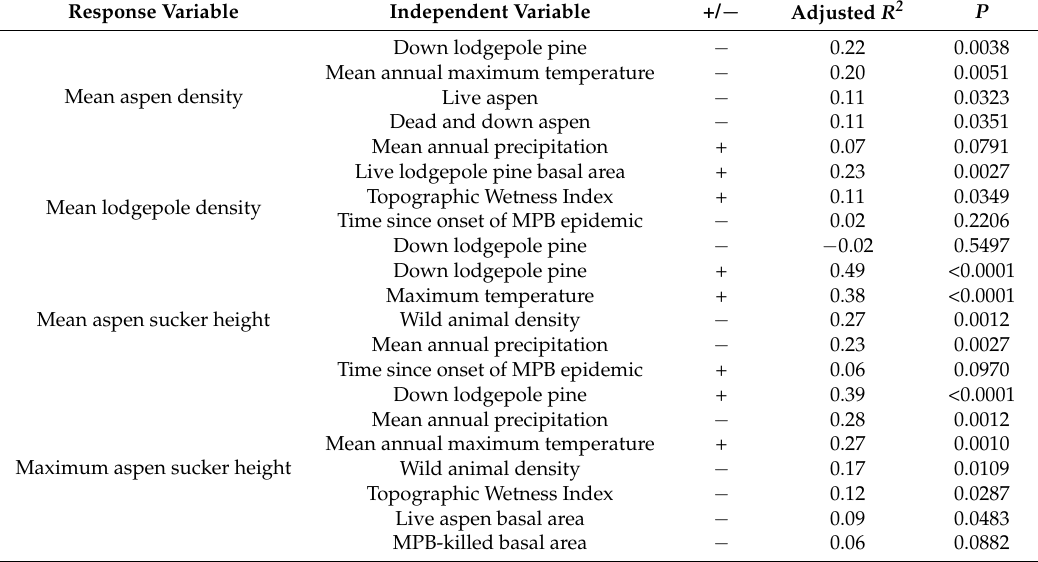
Table 2. Results of linear regression analysis of regeneration density (aspen and lodgepole pine), height (aspen), and independent variables. Independent variables are listed in order of the strength of their relationship with the response variable (as measured by adjusted R 2 ). All independent variables shown had a significant ( α < 0.1) Spearman’s rank correlation with the response variable. Signs (+ or − ) indicate if regression relationship is positive or negative. All variables met assumptions of normality; all variables were log-transformed except for mean annual precipitation and wild browsing index. MPB: mountain pine beetle.